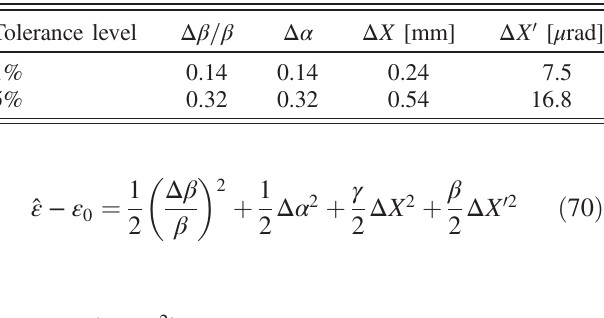
TABLE I. The tolerance levels for mismatch and steering errors for the injection into the SPS. The nominal emittance is ε 1 . 26 × 10 − 7 m rad, and the Twiss parameters at the injection 0 ¼ point are β ¼ 44 . 5 m and α ¼ − 0 . 96